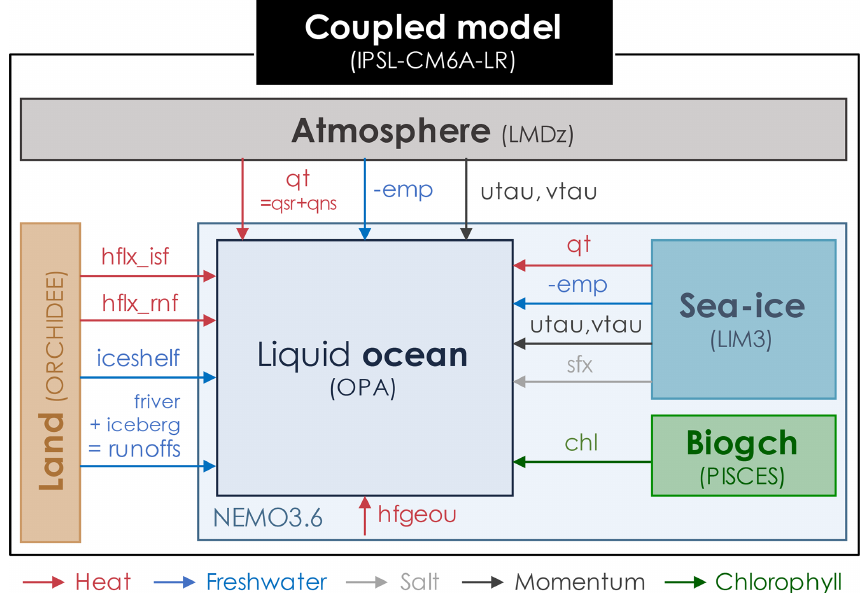
Figure 2. Schematic of the exchanges between the ocean and the other components in the IPSL-CM6A-LR coupled model affecting ocean physics. See Table 1 for the signification of these fluxes. LMDz is the atmospheric model of the Laboratoire de Météorologie Dynamique, and z stands for zoom. ORCHIDEE is the ORganizing Carbon and Hydrology in Dynamic EcosystEms. LIM3 is the Louvain-la-Neuve Ice Model version 3. OPA is the Océan PArallélisé. PISCES is a biogeochemistry model; it is not an acronym. NEMO is the Nucleus for European Modelling of the